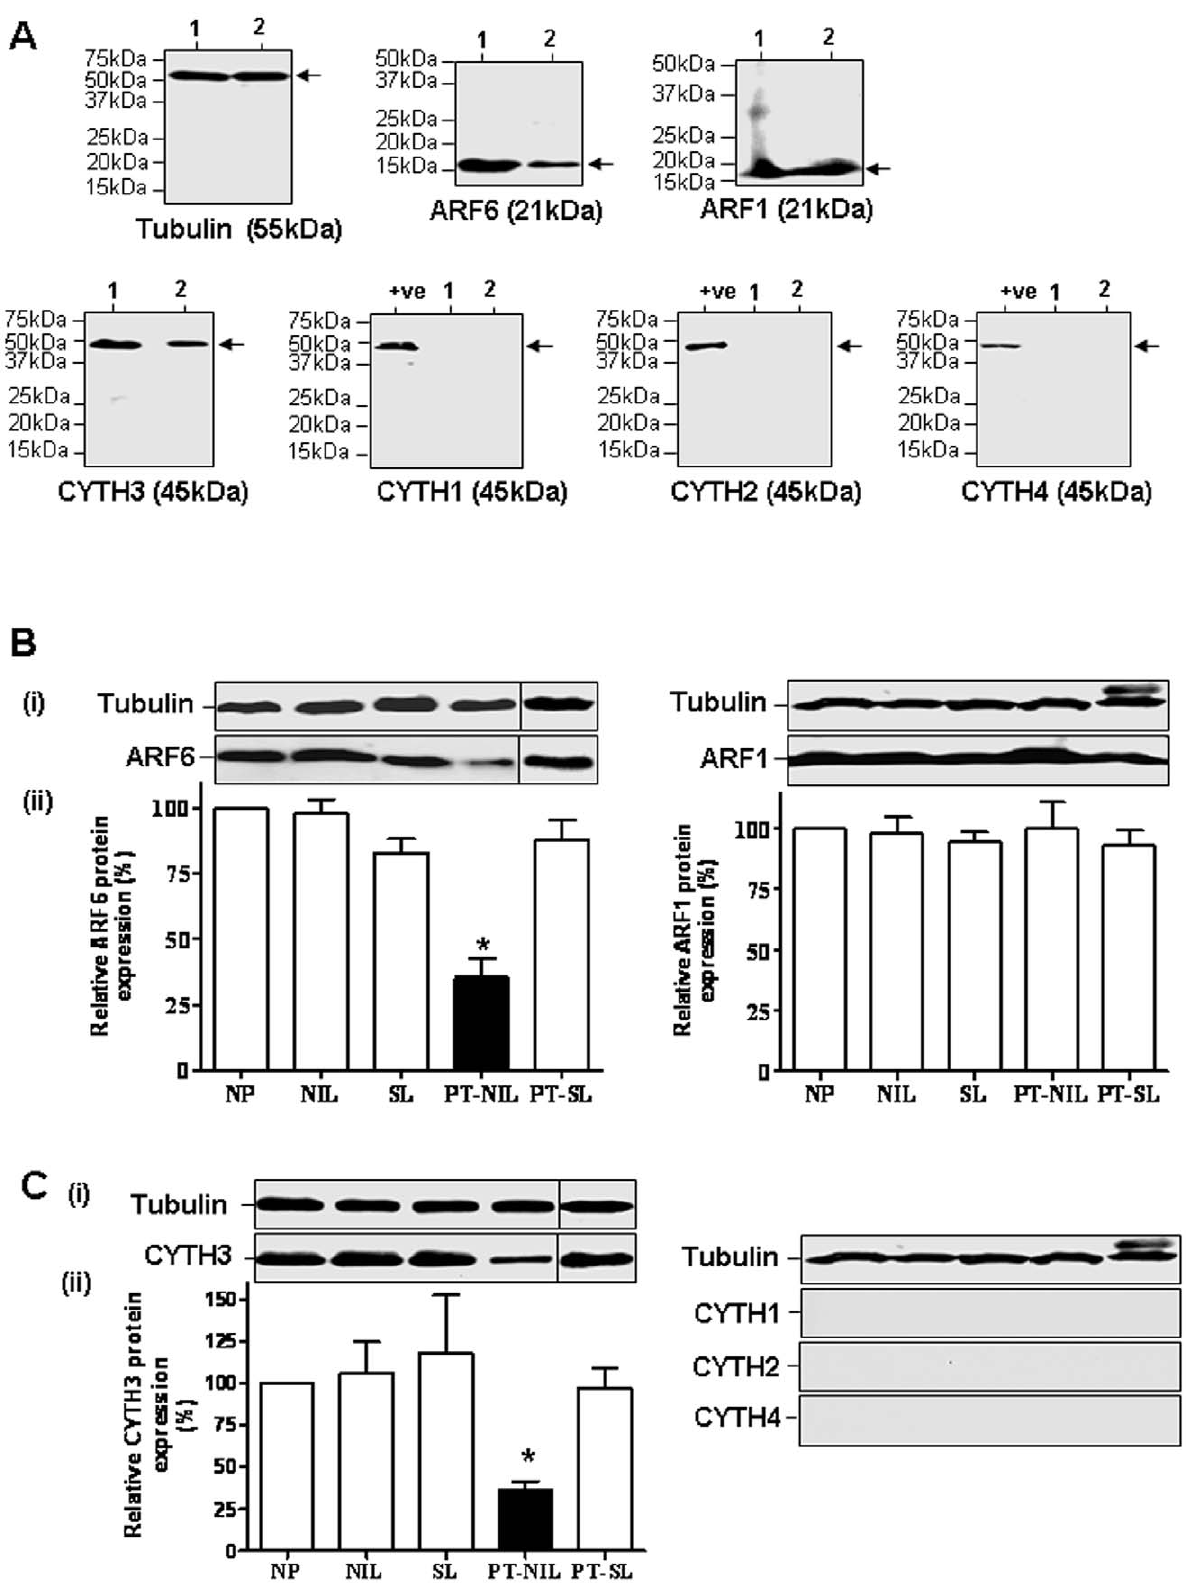
Figure 3. Expression of ARF1, ARF6 and CYTH3 proteins in human myometrium. A. Immunoblot analysis of the expression of ARF6, ARF1, CYTH1-4 and tubulin proteins in human placenta and myometrium. Lanes 1, Placental lysate, and 2, NP myometrium lysate. Immunoblot analysis of ARF6 and ARF6 (B) and CYTH1-4. (C) protein expression in human myometrium of NP, NIL, SL, NP-SL and PT-NIL. The tissue lysate proteins (50 m g)